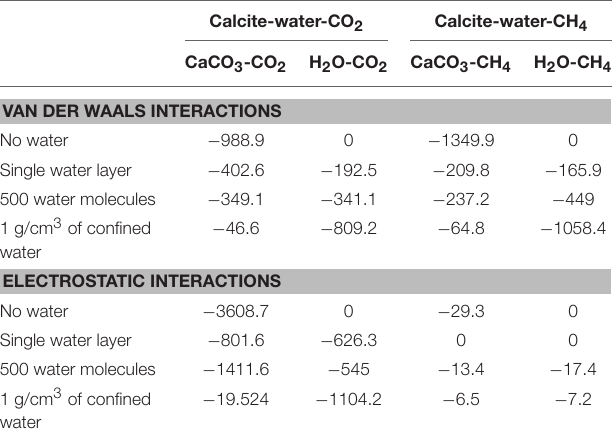
TABLE 3 | Intermolecular interactions (kJ/mol) of calcite-fluids and